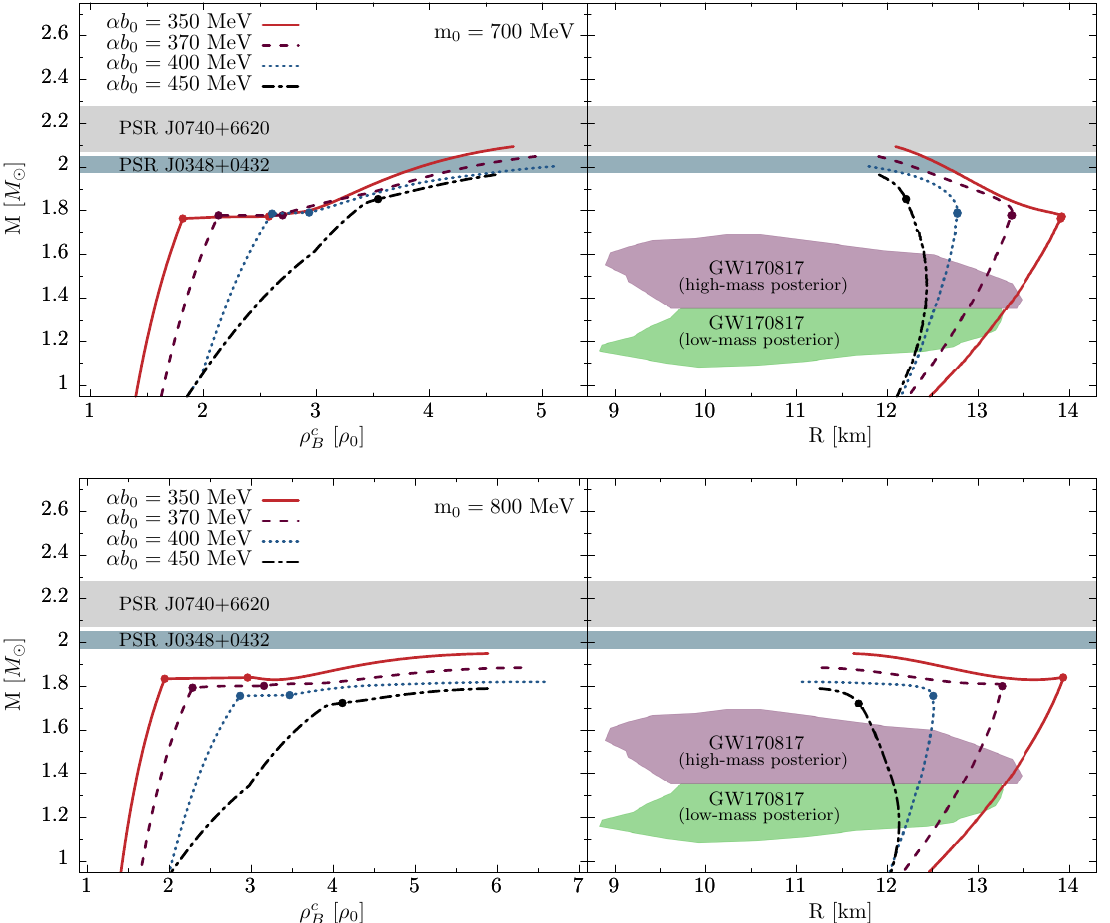
Figure 3. Sequences of mass for compact stars vs. their central net-baryon density ( left ) and vs. radius ( right ) as solutions of the TOV equations for m 0 = 700 MeV ( top ) and m 0 = 800 MeV ( bottom ). The regions between the circles show the coexistence of the chirally broken and chirally restored M (cid:12) constraint [8]. The blue band is the 2.01 ± 0.04 M (cid:12) phases. The gray band shows the 2.17 + 0.11 − 0.10 constraint [32]. The green and purple bands in the right panel show 90% credibility regions obtained from the GW170817 event [9] for the low- and high-mass